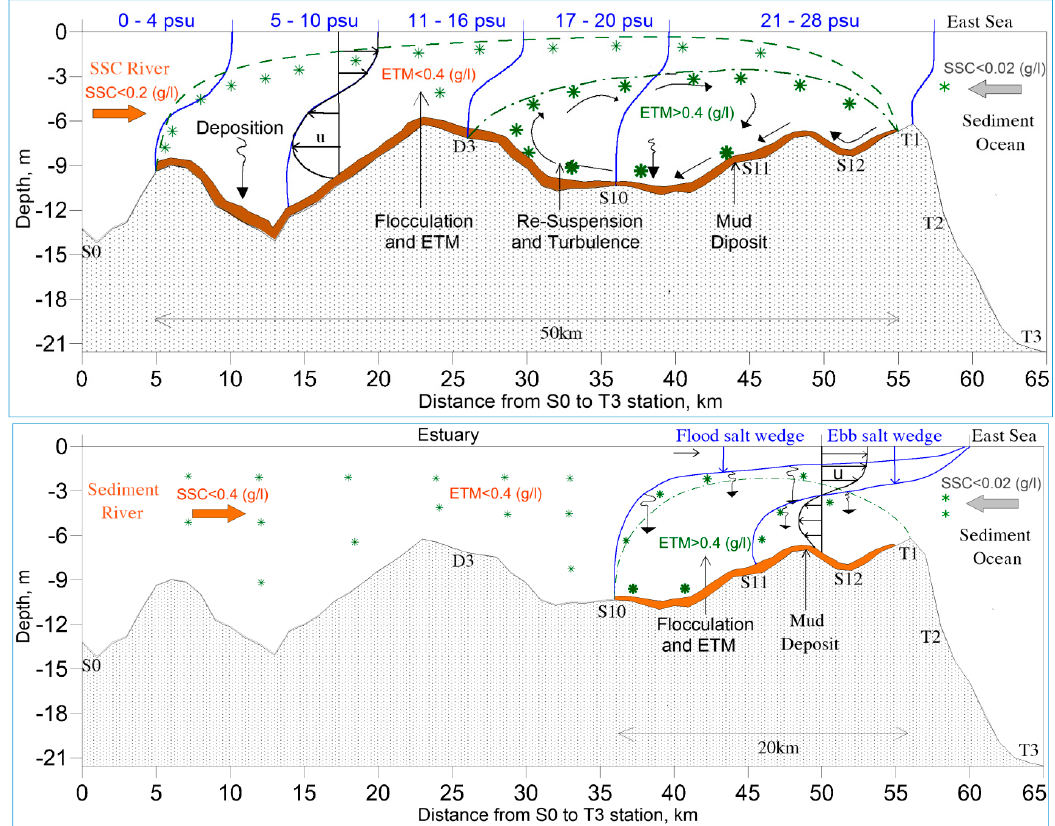
Figure 20. Conceptual model of the estuarine turbidity maximum in the Hau river mouth: dry season ( top panels ) and flood season ( bottom panels ).